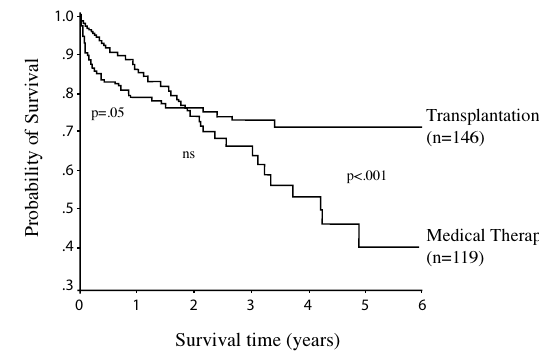
Figure 3 Comparison of patients who were taken on a waiting list for transplanta- tion immediately after referral (Trans- plantation) and who were initially consid- ered too well (Medical therapy). Although therapy of heart failure has changes since publi- cation, these results nicely show the pro- gressive nature of heart failure and the need for ongoing reassessment of prognosis in these patients (adapted from